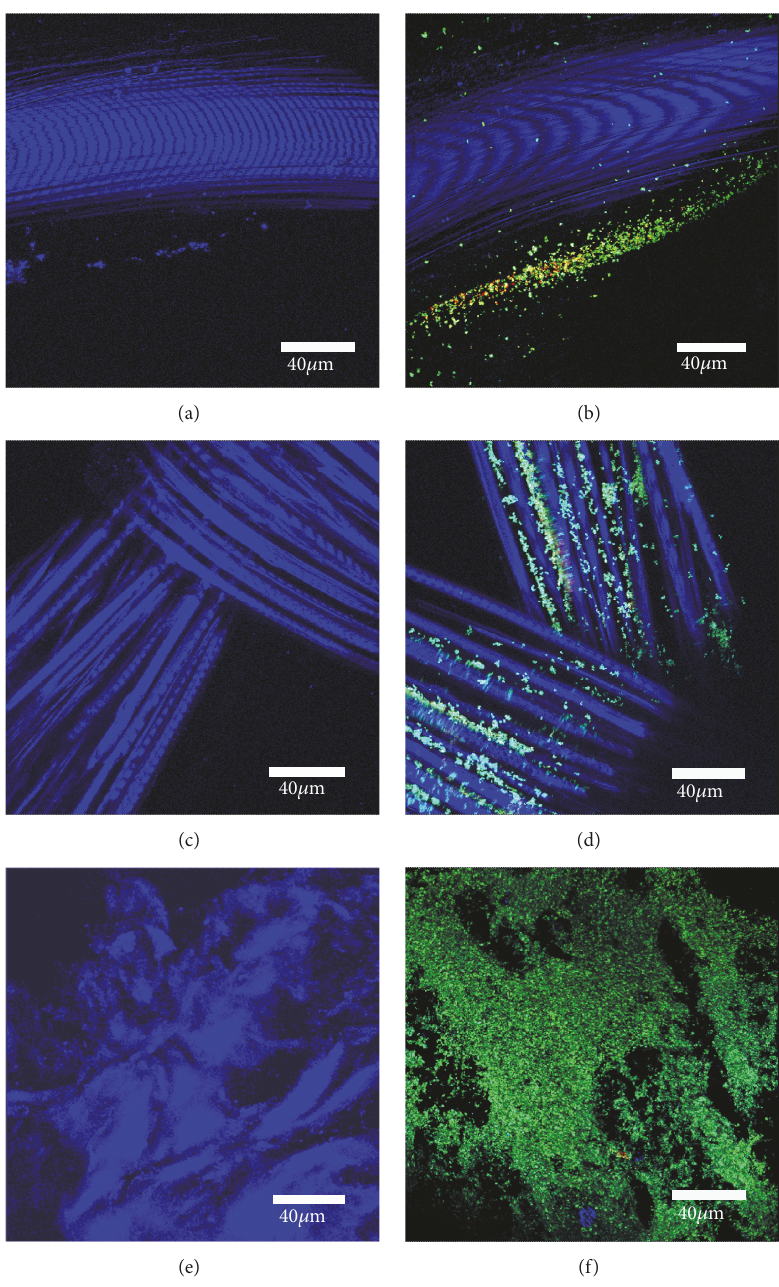
Figure 1: Polypropylene mesh (Images (a)-(b)), polyglactin 910 mesh (Images (c)-(d)), and biologic mesh (Images (e)-(f)) stained with LIVE/DEAD (cid:2) Baclight (cid:3) Bacterial Viability stain and imaged using confocal microscopy. Images (a, c, and e) are mesh following 24hr incubation with BHI while images (b, d, and f) are mesh after 24 hr incubation with Staphylococcus aureus . Live bacteria are stained green while blue represents reflective light from the